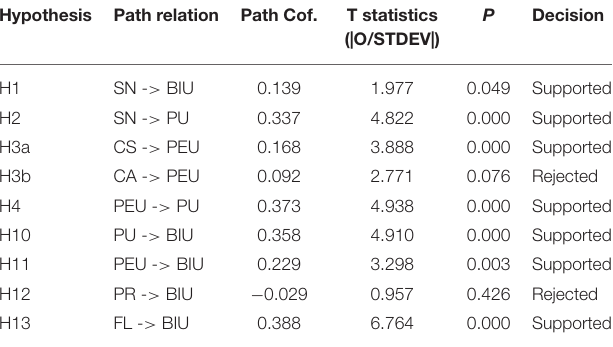
TABLE 12 | Structural estimates (Hypothesis testing). Hypothesis Path relation Path Cof.